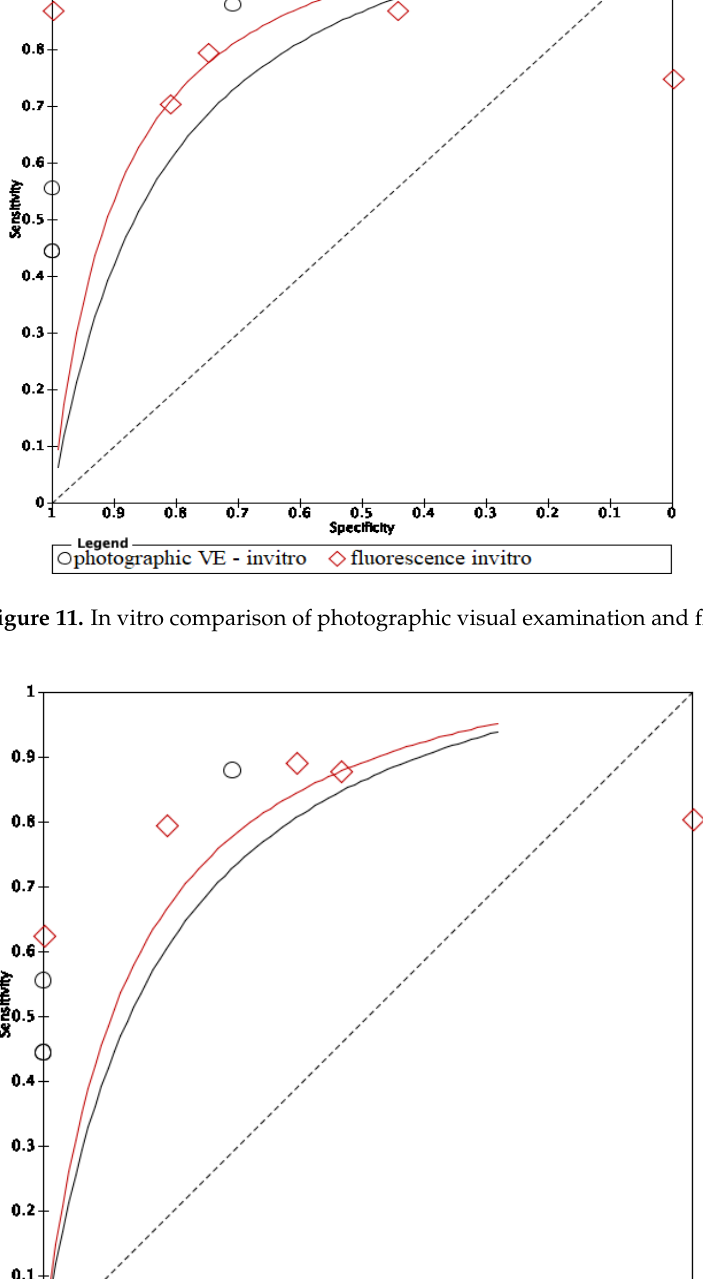
Figure 10. In vitro comparison of fluorescence and visual inspection.